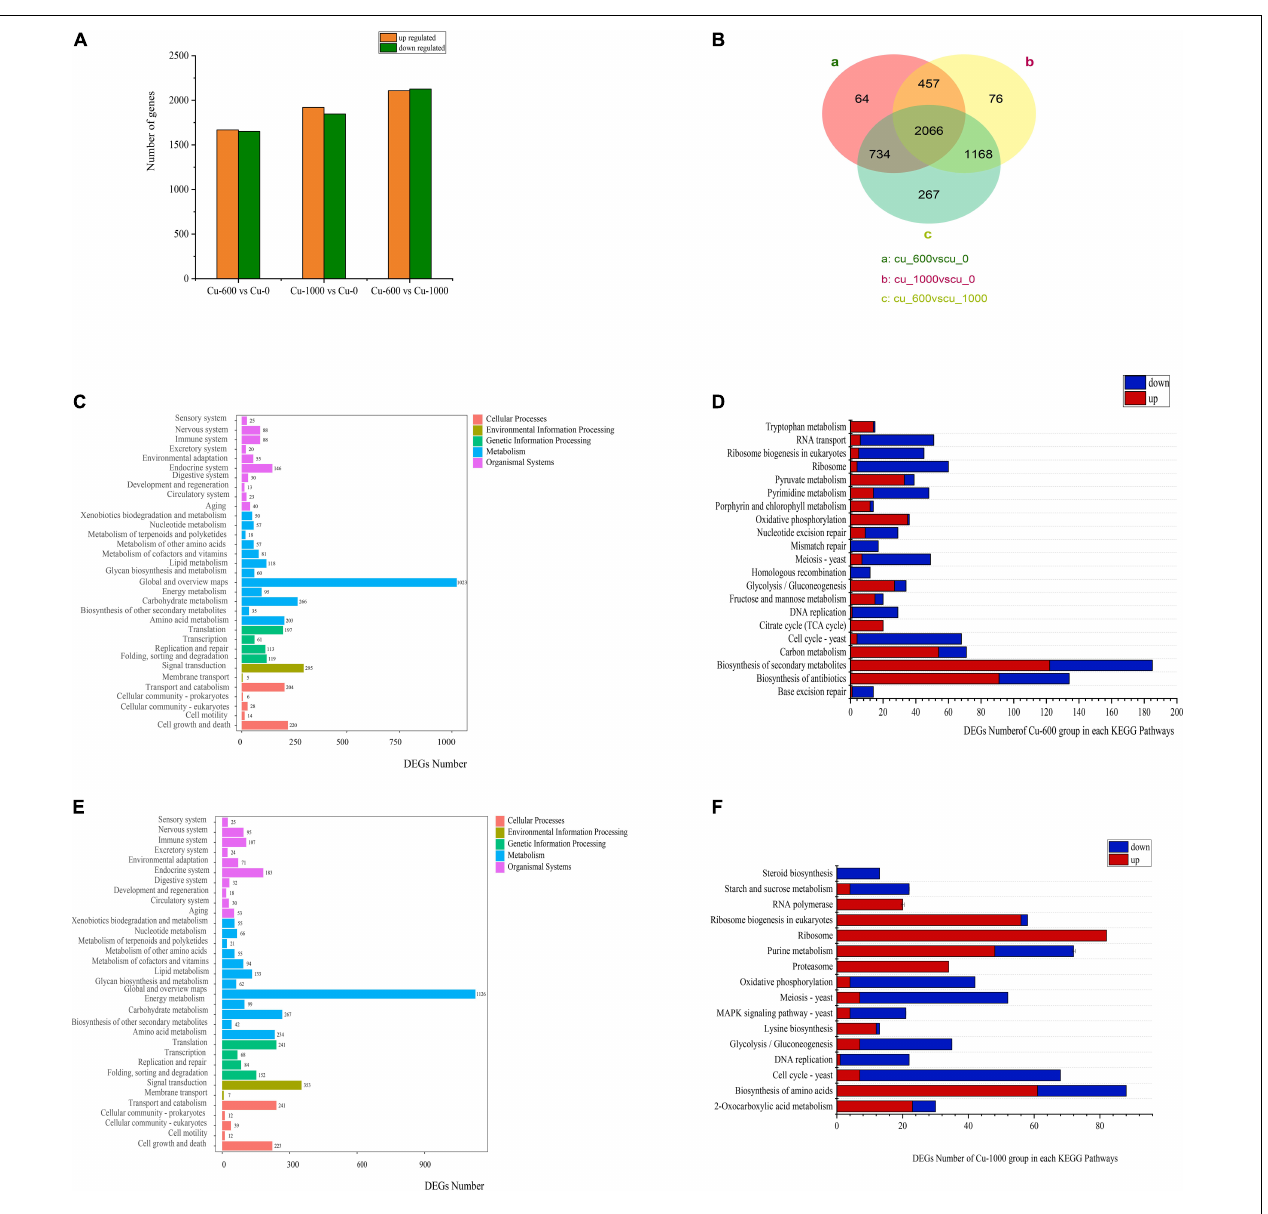
FIGURE 2 | Effects of copper ions stress on GXDK6 gene transcription. (A) Differential genes of GXDK6 under copper ions stress for 12 h. (B) Venn diagram analysis of the differential genes for 12 h. (C) Enrichment pathway of the differential genes in the Cu-600 group for 12 h. (D) Significantly enriched pathway in the Cu-600 group for 12 h. (E) Enrichment pathway of differential genes in the Cu-1000 group for 12 h. (F) Significantly enriched pathway in the Cu-1000 group for 12